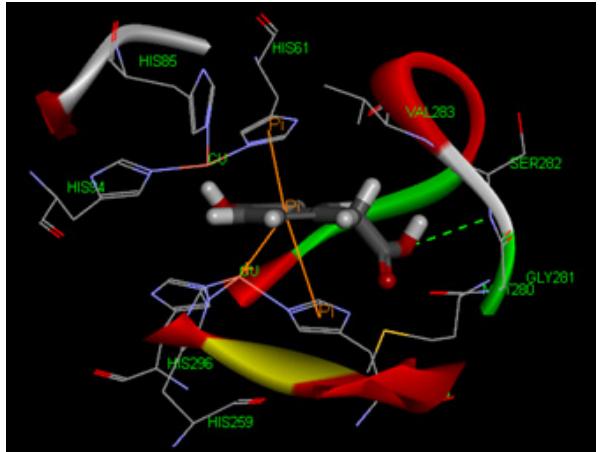
Figure 11. The docking of 4-hydroxyphenylacetic acid ( 5 ) into the active site of mushroom tyrosinase. The acetic acid moiety of 4-hydroxyphenylacetic acid ( 5 ) introduced one hydrogen bond with SER282 and its aromatic ring built the π – π interaction with HIS263, HIS61, and copper ion.